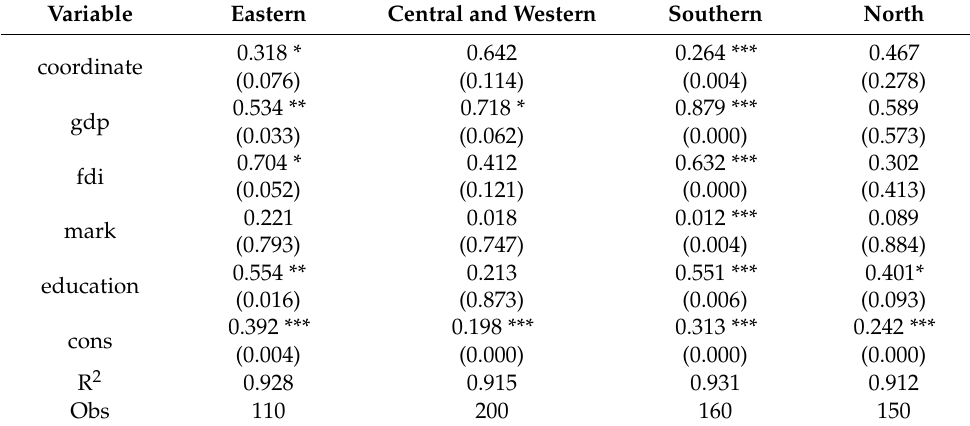
Table 4. Analysis of regional